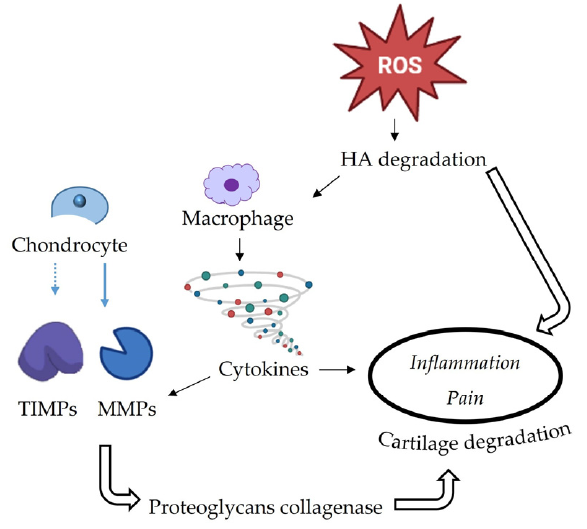
Figure 2. Triggered mechanisms in cartilage destruction, associated with painful TMJ (adapted from